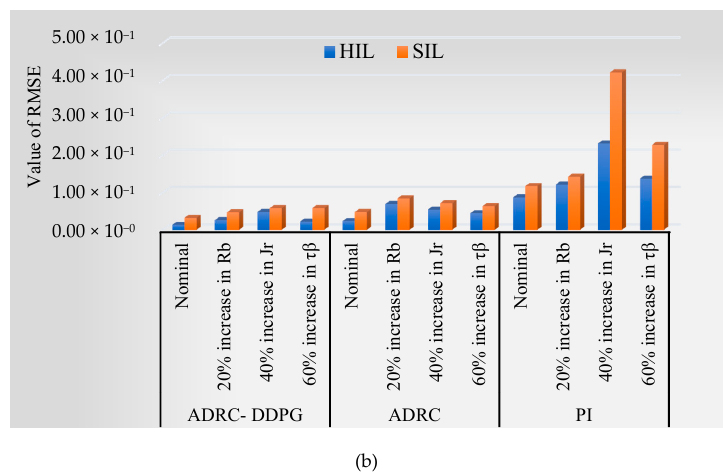
Figure 16. Bar chart compassion of standards under the parametric uncertainties: ( a ) values of MSE; ( b ) values of RMSE.